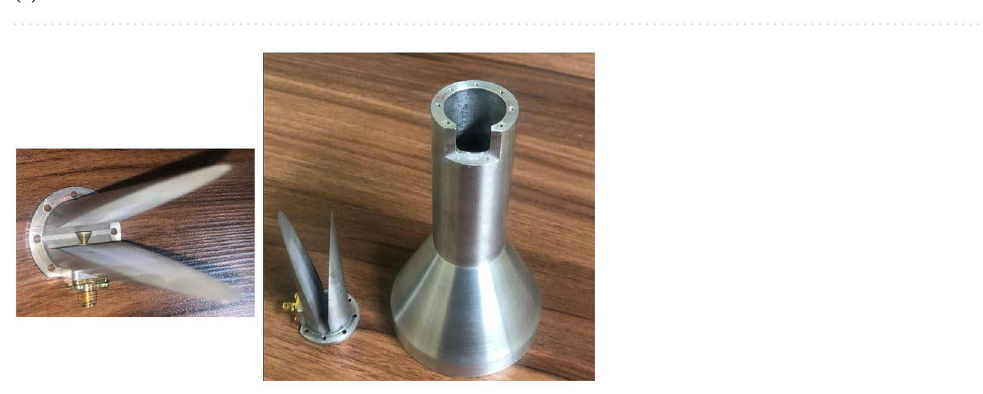
Figure 11. 3D demonstration of the pattern designed by the PRT+TFPS method. ( a ) f=14 GHz. ( b ) f=17 GHz. ( c ) 19 GHz.